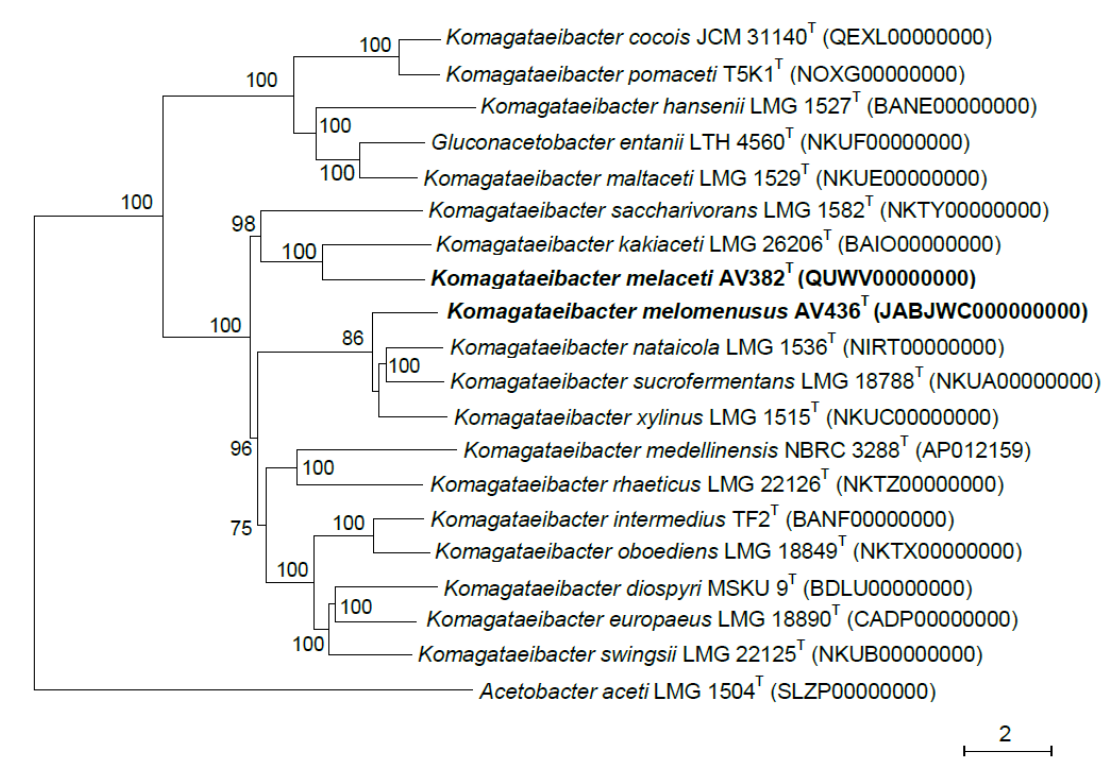
Figure 2. Phylogenetic reconstruction based on core genes (46 at minimum BlastP identity of 90%) of the type strains of species of the Komagataeibacter genus. Strains AV382 and AV436 representing novel species are in bold. The tree was constructed using the maximum-likelihood method. Bootstrap values are indicated at branching (1000 replicates). GenBank accession numbers are given in brackets and the scale bar represents 2% estimated sequence differences.